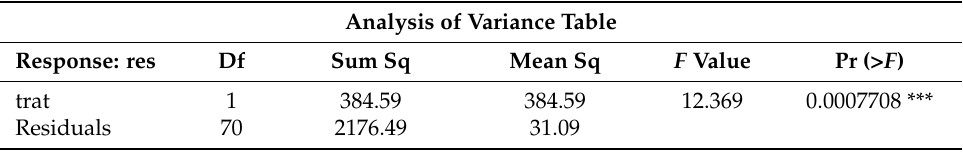
Table A9. R output of ANOVA among the residues generated from the estimation of AGDM using species equation and age specific equation with C 12.